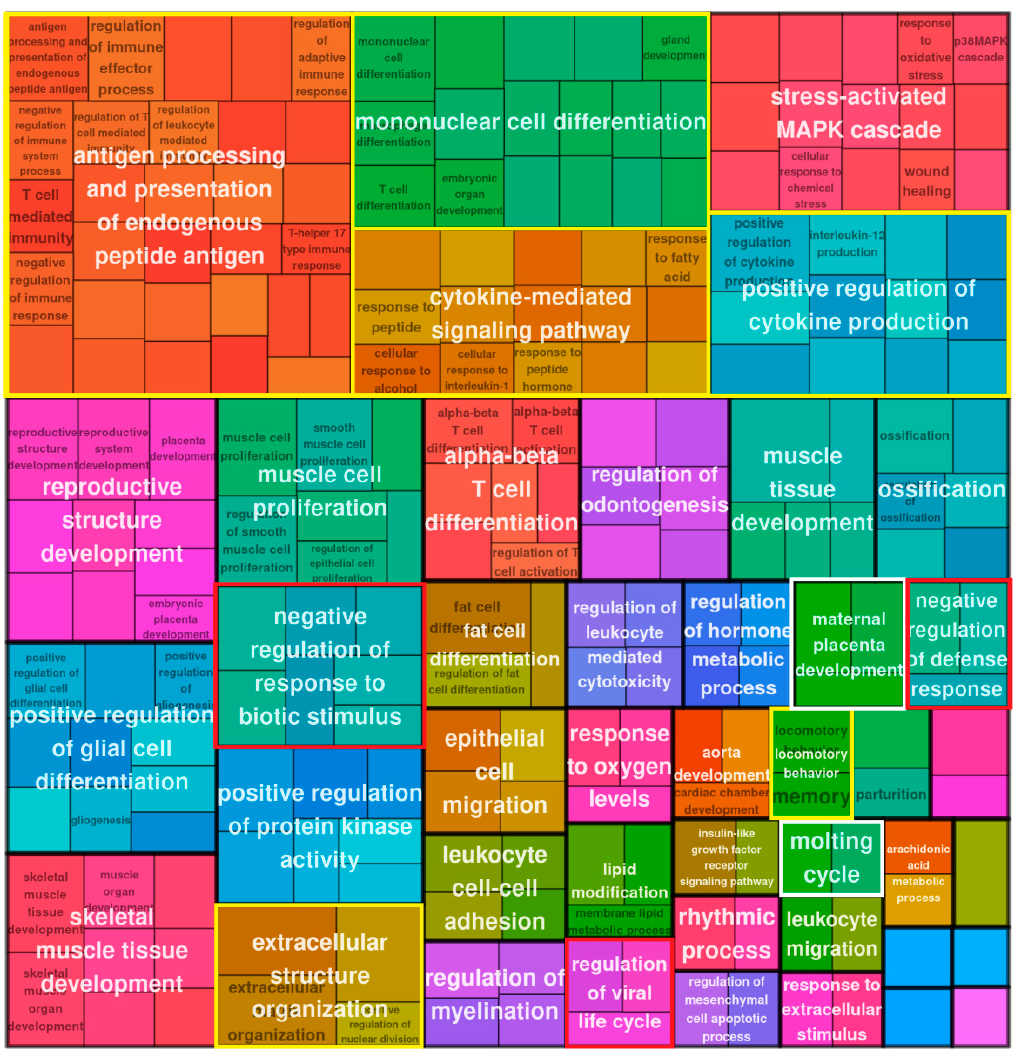
Figure 4. Treemap plot representation of the GO BP enrichment analysis results (GO modules with hypergeometric test pAdj < 0.05 classed as enriched) for bivalent genes upregulated in MDA-MB-231 cells on day 16 post-DOX. Table 1. The expression of differentially expressed (LogFC, compared to NT) genes sensing cytosolic DNA triggered by the AIM2